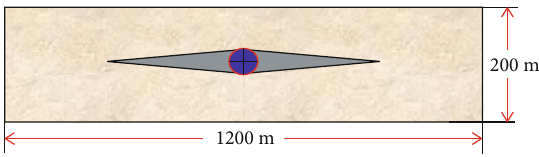
Figure 1: The rectangle reservoir model.